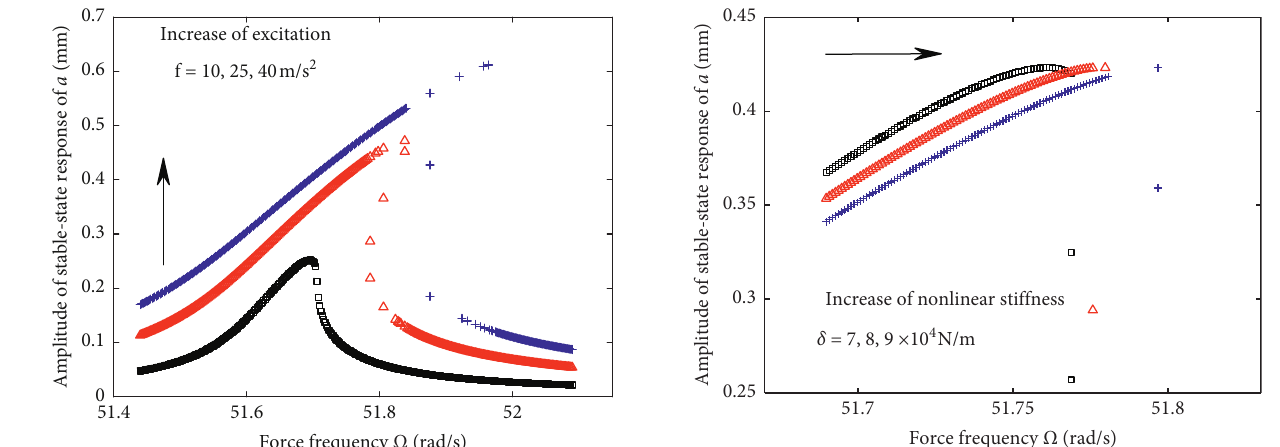
Figure 4: Effect of nonlinear stiffness on the stable vibration solution. Figure 2: Effect of excitation acceleration on the stable vibration